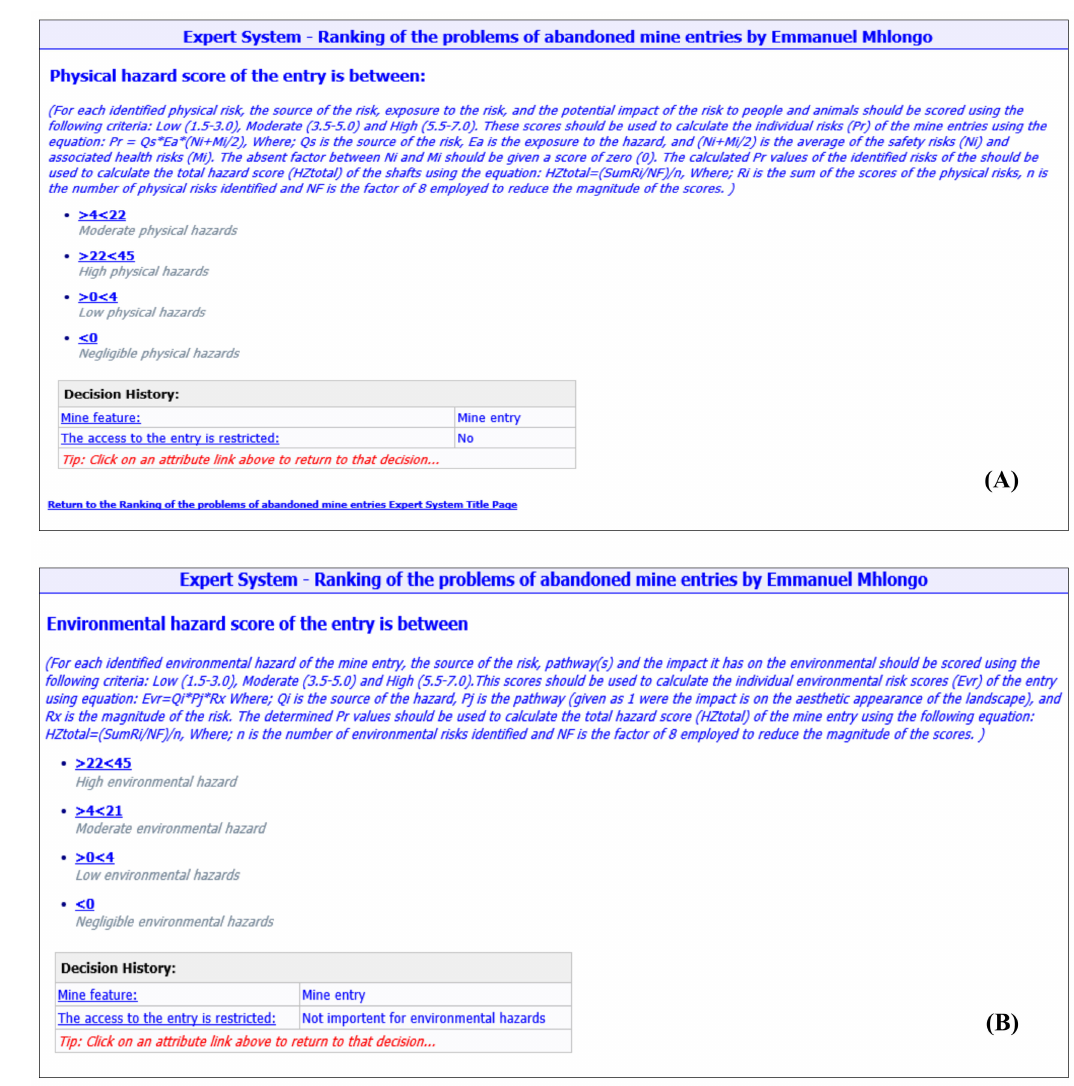
Figure 5. An illustration of the instructions of the expert system concerning the hazard score determination. ( A ) is the instructions for determination of environmental hazard score and ( B ) is for the determination of physical hazard